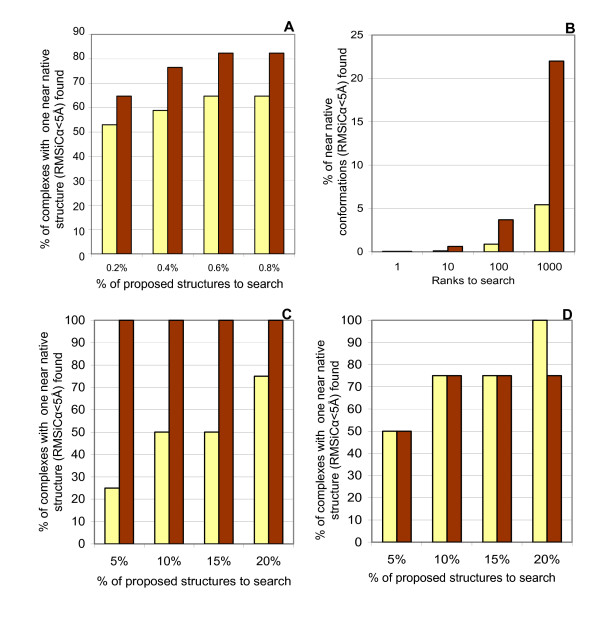
Improvement of prediction quality (testcases from literature). The light yellow bars show the percentage of complexes for which a near-native solution (RMSiCα<5Å) is found without the optimised weighting factors. The brown bars show the results after the application of the weighting factors. (A) for enzyme-inhibitor (100%: 17 complexes) (C) for antibody-antigen (100%: 4 complexes) and (D) for other complexes (100%: 4 complexes), (B) shows the percentage of near-native structures found within the top ranks for enzyme-inhibitor complexes (100%: 1956 structures); Also for the complexes which were not part of the optimisation procedure a clear enrichment of near-native structures on the lower ranks can be seen.